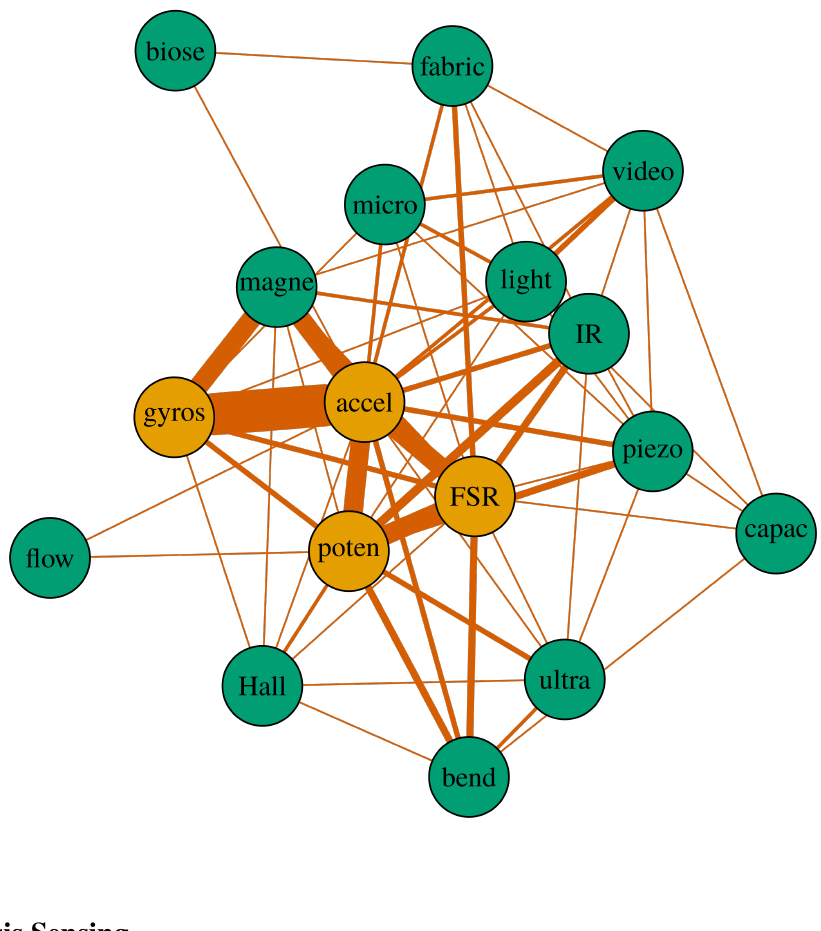
Figure 5. Co-occurrence of sensors: line thickness is proportional to the number of instances the connected sensors were used in the same application. Sensor names were